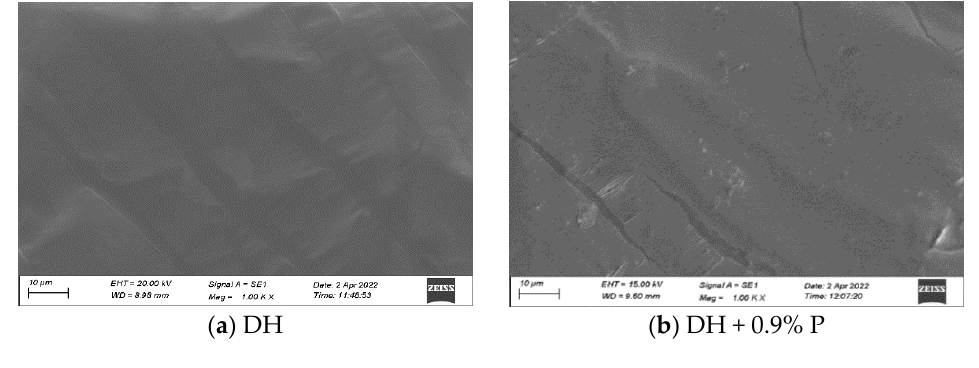
Figure 2. The preparation process for PPA-modified asphalt and PPA/SBR-modified